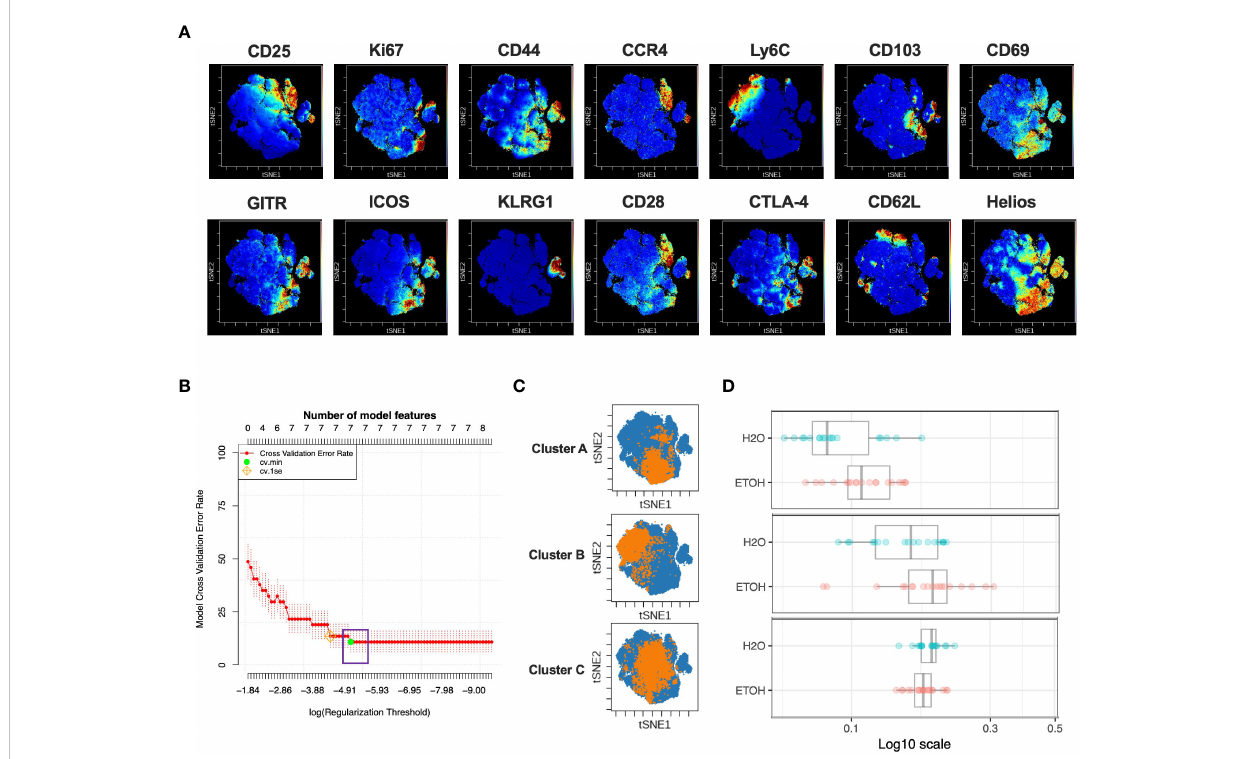
FIGURE 2 Combined CITRUS and viSNE analysis revealed three CD4 + T reg clusters associated with chronic alcohol exposure. (A) CD4 + T reg subset samples from water- and alcohol-drinking mice were equally downsampled to 4000 events to detect 10% subpopulations with CV=5%. viSNE mapping was performed using all 14 available markers for clustering (CD3, CD4, CD8 and Foxp3 were excluded). Iterations were set to 2000, perplexity 70 and theta 0.5. (B) CITRUS analyses were performed on the events comprising each viSNE plot. Samples were grouped by alcohol versus water exposure, the same 14 channels used for viSNE were selected for clustering by abundance. LASSO modeling was selected, minimum cluster size was set to 10%, false discovery rate 1% (note: this is irrelevant for LASSO), cross validation folds 10, and scales were normalized. The CV.MIN output was selected from the LASSO analysis. A representative model error rate plot is show. (C) CITRUS replicates were compared using the “ clusters-cv_min ” output fi le histograms. Clusters that were altered in alcohol versus water drinkers were identi fi ed Clusters (A – C) . Representative clusters from one CITRUS run were concatenated and individually overlaid onto their corresponding viSNE plot shown in (A) . (D) Representative CITRUS feature plot corresponding to (C) showing differences in cluster frequency between alcohol and water exposed animals. E) The statistical frequencies of Clusters A (8.7 ± 0.6% vs . 6.8 ± 0.6%, p=0.04) and B (4.6 ± 0.4% vs . 2.8 ± 0.3%, p=0.002) were increased in alcohol exposed mice, while the frequency of Cluster C (2.4 ± 0.1% vs . 4.5 ± .2%, p <0.0001) was decreased. Data were tested for normality and compared with either t test or Mann-Whitney